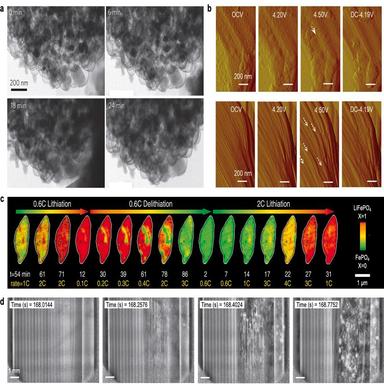
The application of in-situ imaging techniques in battery research. (a) Lithiation process of pomegranate-like silicon particles with sufficient (40 nm) void space observed via in-situ TEM. Reproduced with permission. Copyright 2014, Springer Nature. (b) Surface evolution of a single-crystalline LiNi0.76Mn0.14-Co0.1O2 particle during electrochemical cycling observed with in-situ AFM. Reproduced with permission. Copyright 2020, AAAS. (c) State of charge heterogeneity within a single